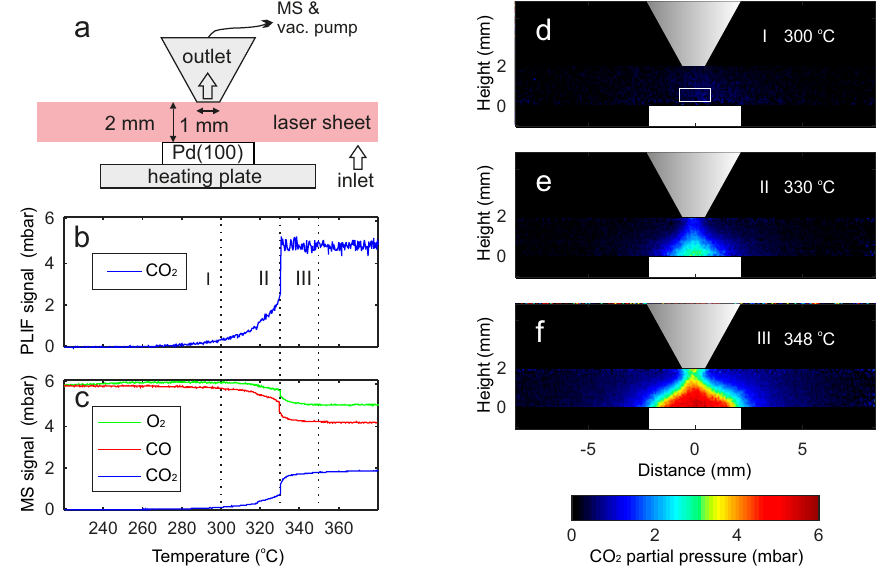
Figure 1. CO 2 distribution over a Pd(100) single ‐ crystal catalyst: ( a ) schematic of the nozzle which is connected to a vacuum pump and a mass spectrometer; ( b ) average CO 2 planar laser ‐ induced fluorescence (PLIF) signal inside the white hollow box above the sample indicated by the white solid box; ( c ) Mass spectrometer (MS) profiles of O 2 , CO and CO 2 ; ( d – f ) CO 2 PLIF images (10 laser ‐ shot averaged, representing a time interval of 1 s) recorded at 300, 330 and 348 °C during the temperature ramp at a constant rate of 16 °C/min.